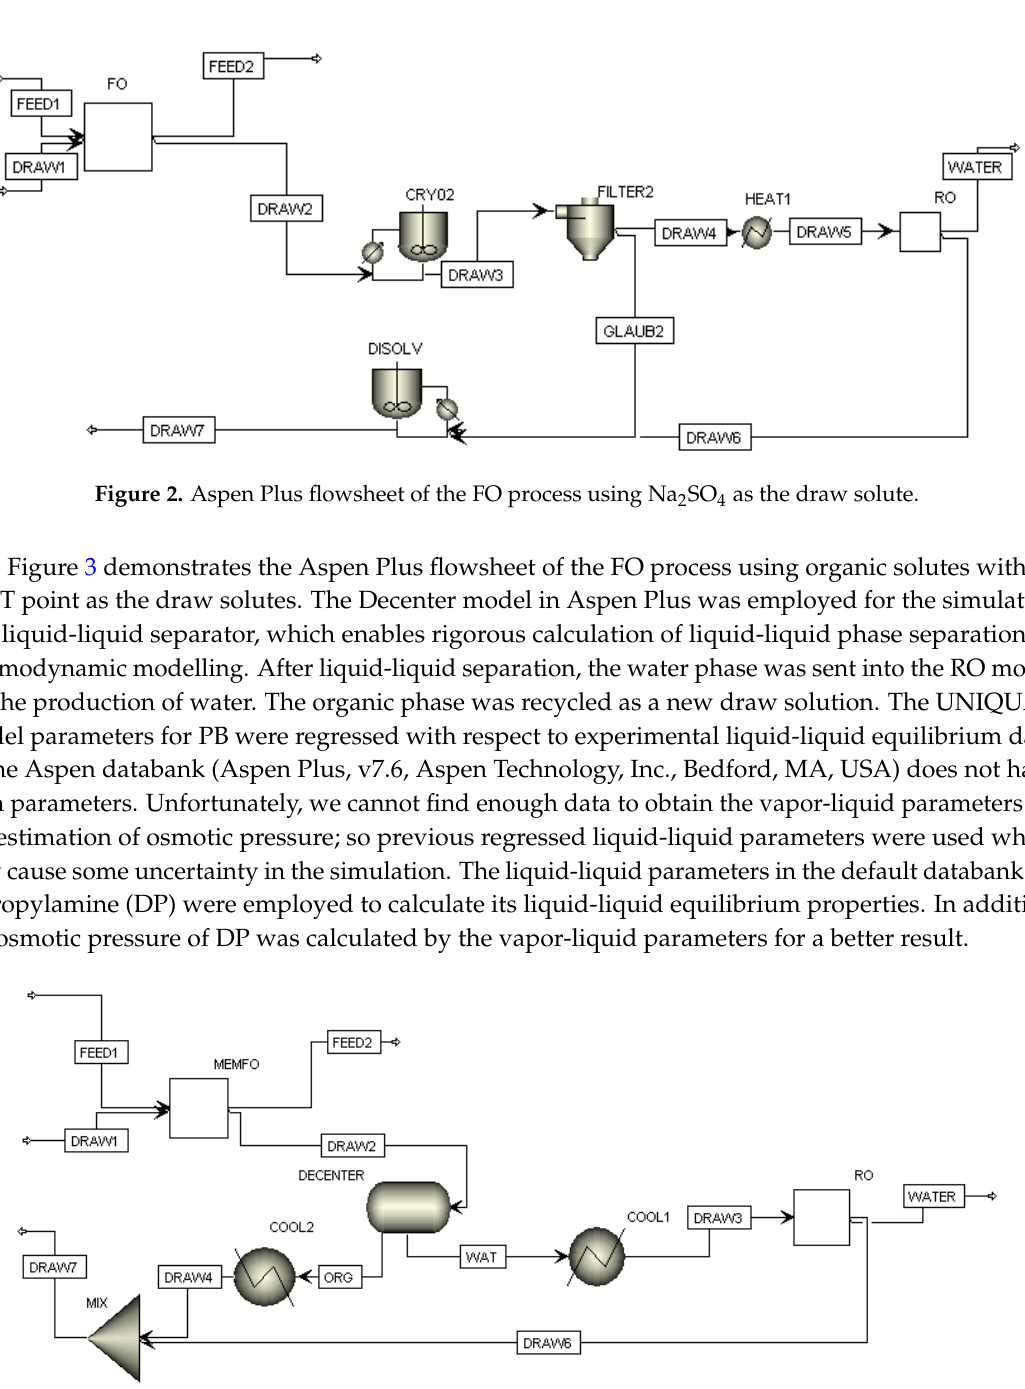
Figure 3. Aspen Plus flowsheet of the FO process using organic solutes with a LCST point as the draw solute.